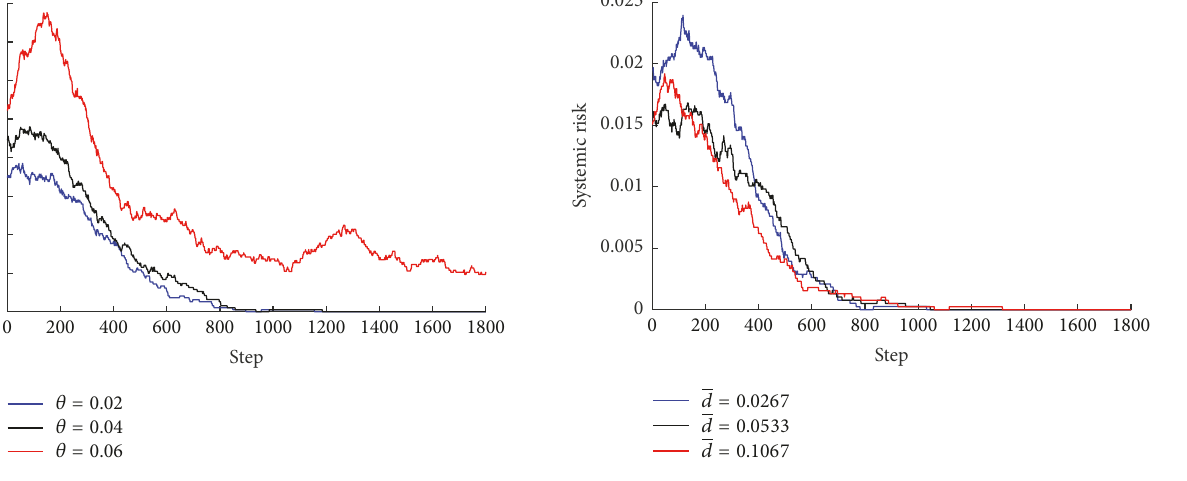
Figure 6: Systemic risk under different values of 𝜃 . The parameters are set as 𝑑 = 0.0533 , 𝛿 𝑎 V 𝑒 = 0.009 , 𝑝 = 0.05 , 𝐶 = 0.03 , 𝜎 𝐴 = 0.15 , = 0.25 , 𝐴 = 1000 , 𝑤 = 500 , 𝜒 = 0.3 , 𝛽 = 0.25 , 𝐵𝑎𝑛𝑘𝑁𝑜 = 200 , 𝜎 𝑤 𝐴𝑠𝑠𝑒𝑡𝑁𝑜 = 150 , 𝑟 = 0.004 , and 𝑟 = 0.008 . 𝑎 𝑏